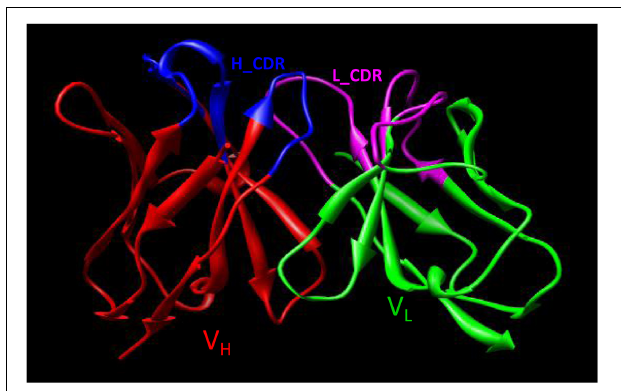
FIGURE 4 | The 3D Fv structure of YG1 derived from computer-guided homology modeling and molecular docking methods. The red ribbon denotes the main carbon atom orientation of VH, the green ribbon denotes that of VL, the blue ribbon denotes the CDR of VH, and the pink ribbon denotes the CDR of